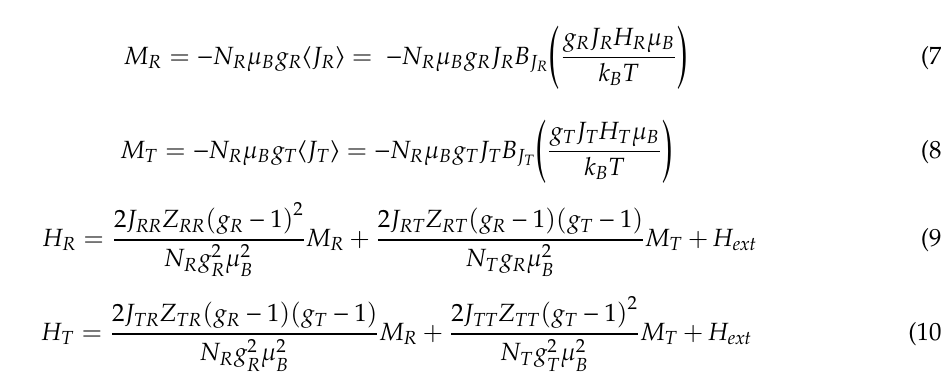
Figure 8. The M FC ( T ) dependence at μ 0 H = 5 T and the results of MFT analysis for the Gd 0.4 Tb 0.6 Co 2 .